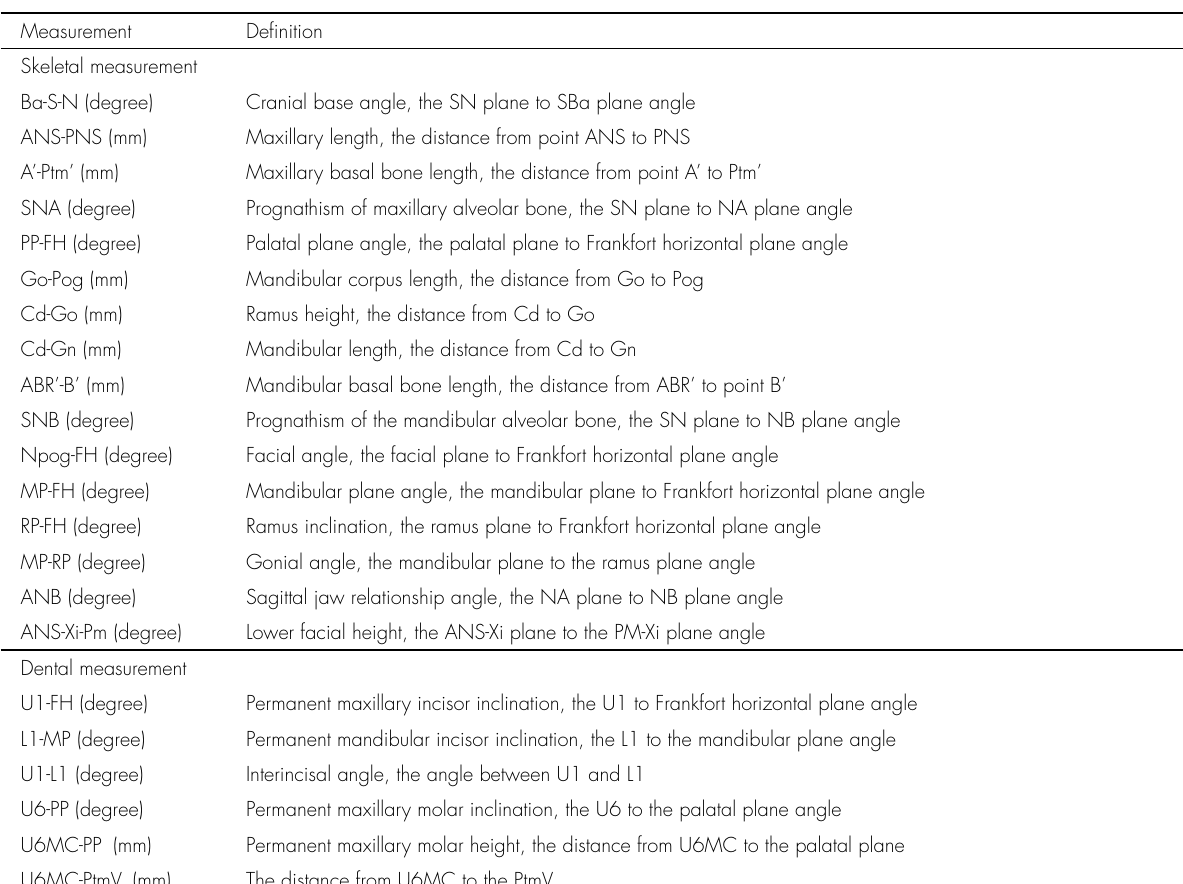
Table II. Definition of measurements used.